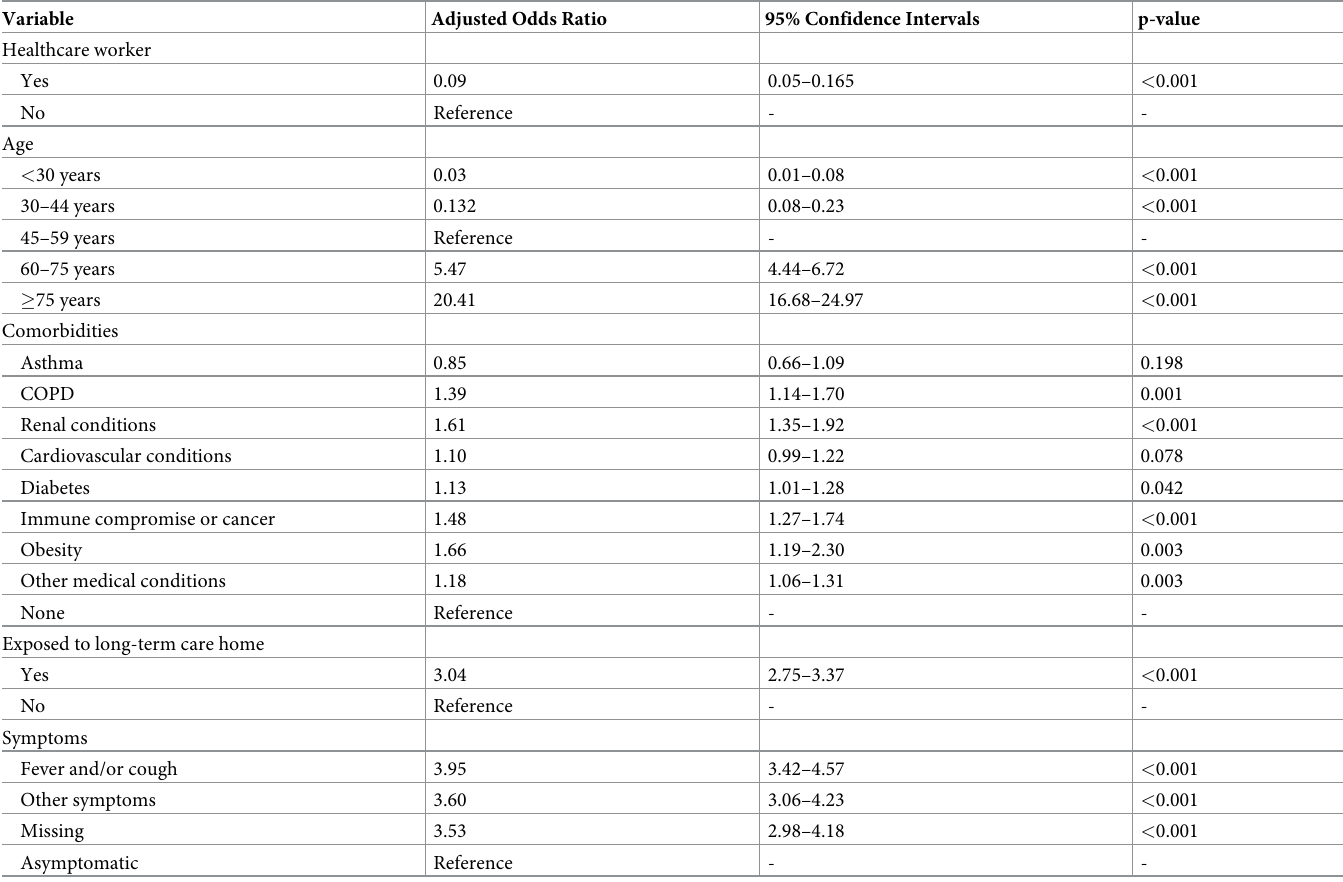
Table 4. Multivariable logistic regression model evaluating risk of death subsequent to SARS-CoV-2 infection.